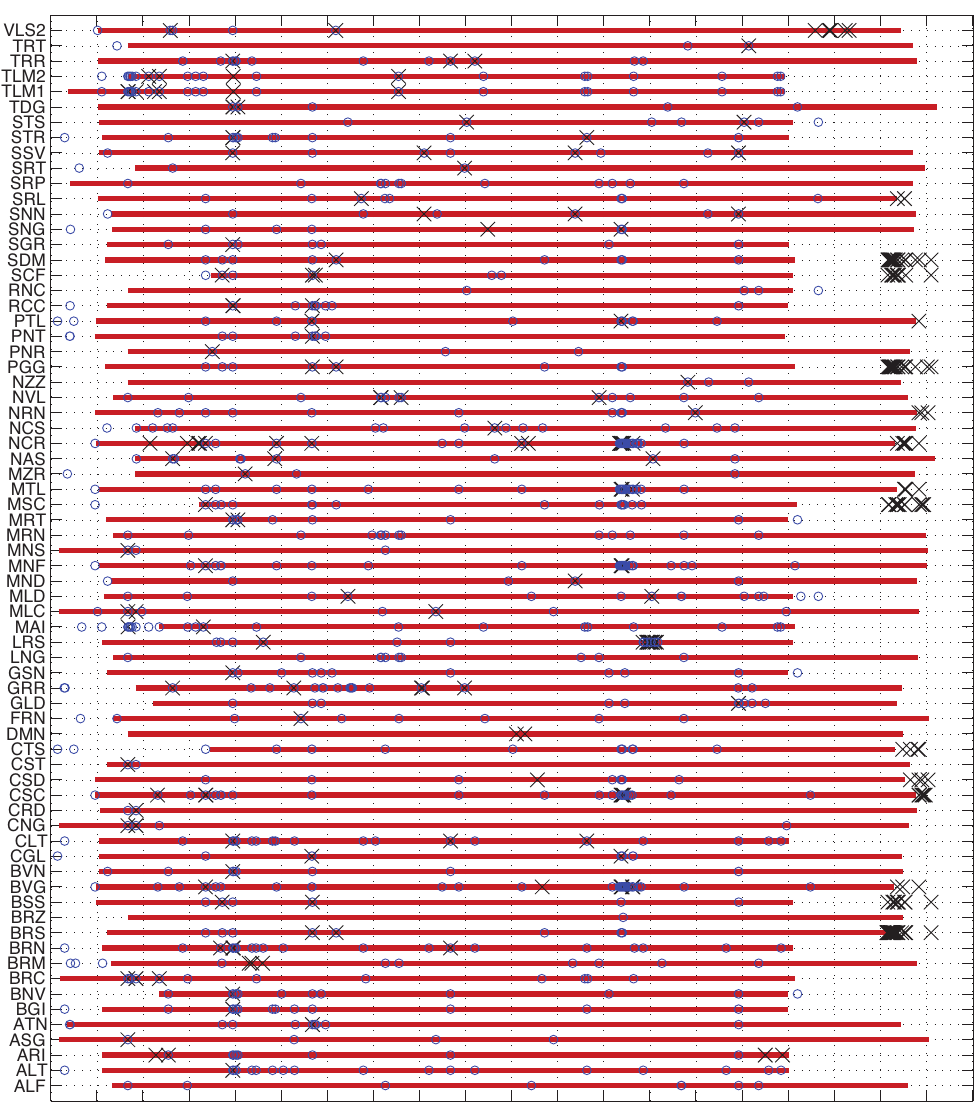
Figure 1. ON–OFF status for accelerometric stations declared to be continuously operating for at least 30 years, as reported on ITACA V1.1 database (Pacor et al., 2011, 2013). Blue circles show potential triggering conditions, computed as (mean PGA + 1 sd) > 0.01g, using CPTI11 earthquake catalogue (Rovida et al., 2011) and ITA10 GMPE (Bindi et al., 2011); black crosses are the effective recordings available. Data acquired on continuous-mode recording in 2009–2011 have not been considered for the existing time gap between the analogue and new digital